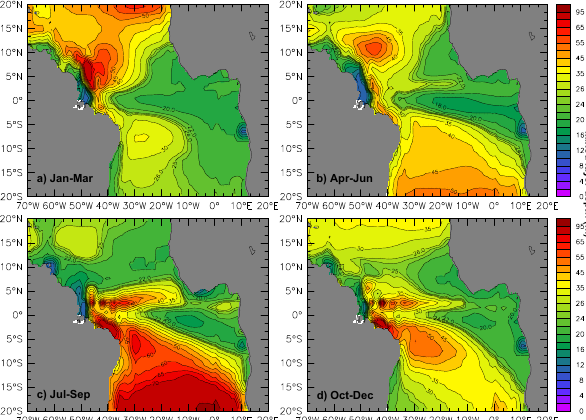
Fig. 10. Modeled average (1998-2005) seasonal surface mixed layer (SML) depths in the tropical Atlantic Ocean, in meters; (a) January–March; (b) April–June; (c) July–September, and (d) October–December. SML values are did not change in the consid- ered TODAY, NO_RIVER, S_AMERICA, and AFRICA scenarios. The coupled model ocean physics (NEMO), i.e. circulation, tem- perature, salinity, freshwater, heat balance, wind forcing, has not been changed in any of the four simulations considered in this